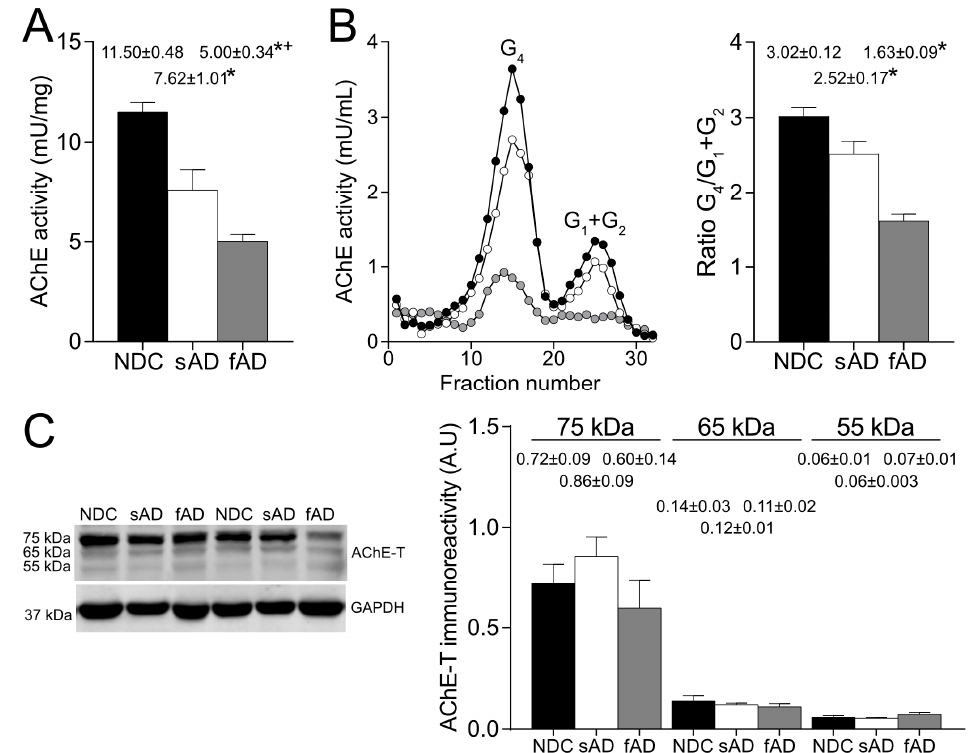
Figure 1. Brain AChE enzymatic activity, molecular forms pattern, and protein levels. ( A ) AChE enzymatic activity expressed in mU/mg of total protein measured in brain extracts from non-demented controls (NDC), sAD, and fAD patients (n = 4 for each group). ( B ) Molecular forms of AChE were separated by ultracentrifugation on sucrose gradients and were identified (tetramers: G4; light monomers and dimers: G1 + G2) in each fraction by comparison with the position of molecular weight markers catalase (11.4S) and alkaline phosphatase (6.1S). Representative profiles for NDC ( ● ), AD ( ○ ), and fAD ( ● ) patients are shown. A (G4)/(G1 + G2) ratio was calculated (right panel). ( C ) Representative Western blot showing immunoreactive bands for AChE at 75, 65, and 55 kDa and the loading control protein, GAPDH, at 37 kDa. The antibody used for AChE determination (A11) was specific for the AChE ‐ T transcript. To the right, densitometric quantification of AChE ‐ T immunoreactive bands in brain extracts normalized to the housekeeping protein GAPDH. The graphs represent mean ± SEM. Significantly different (one ‐ way ANOVA test with Tukey’s multiple comparisons, p < 0.05) from the NDC group (*) or from sAD (+) is indicated.